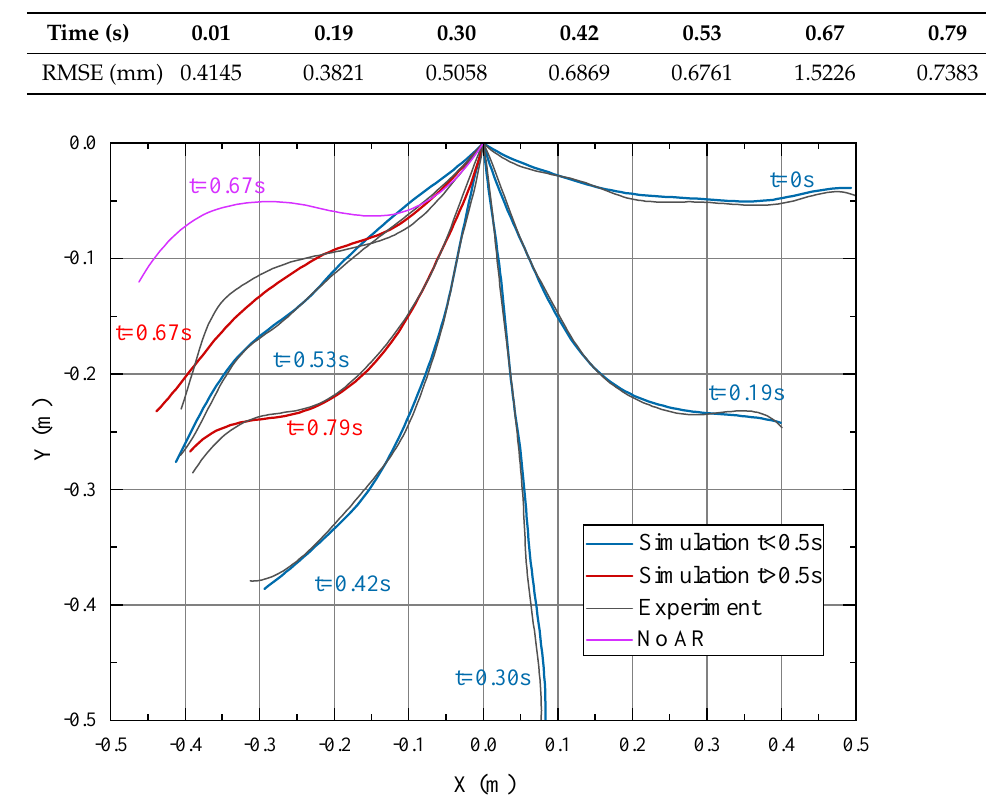
Table 10. The root mean square error in different time.